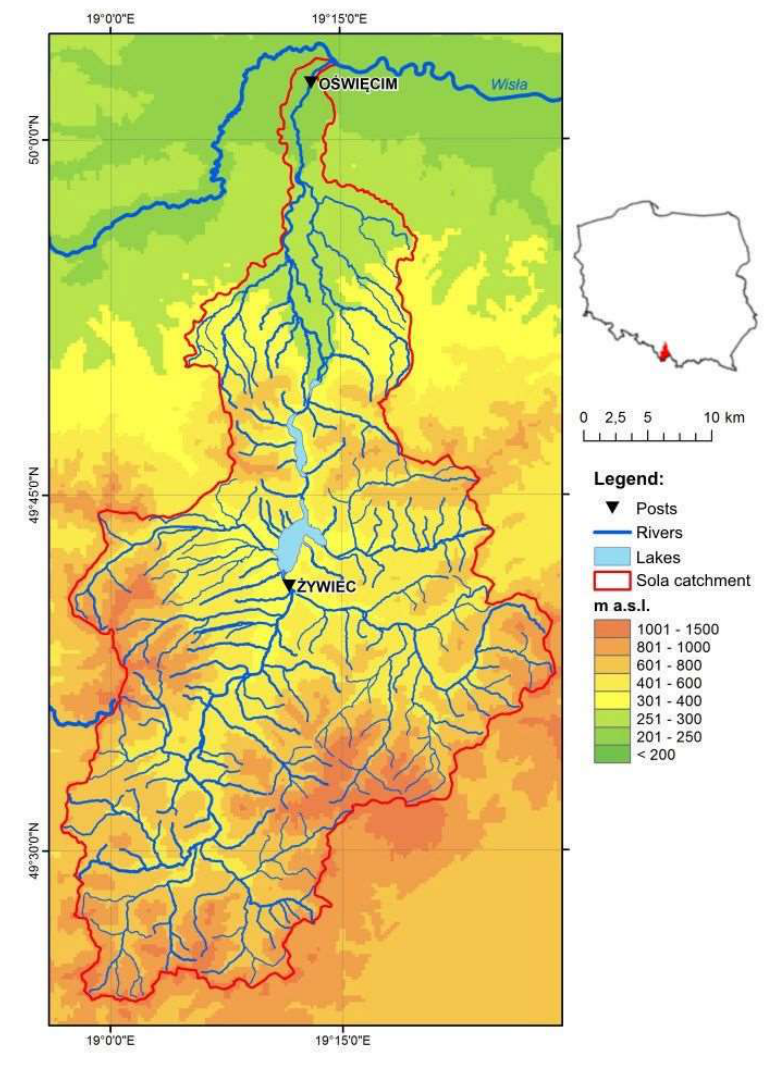
Figure 5. Sola River catchment.